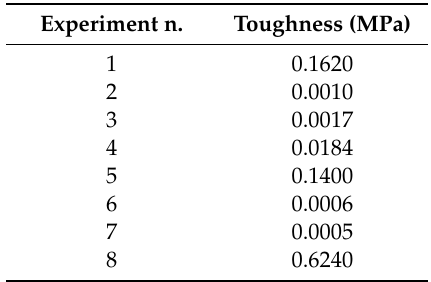
Table 8. Vector 𝑦(cid:3364) containing the value of toughness measured for each mix. Table 8. Vector y containing the value of toughness measured for each mix. Experiment n. Experiment